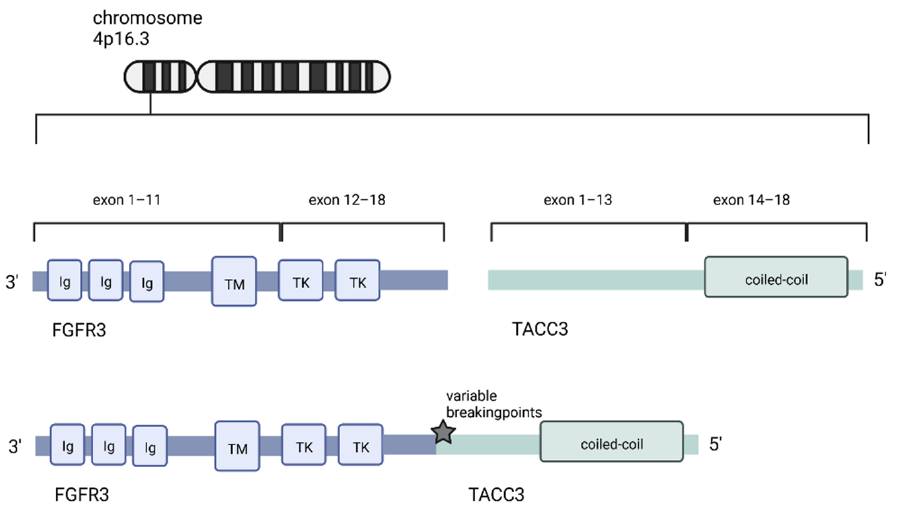
Figure 2. The FGFR3 and the TACC3 gene are both located on chromosome 4p16.3. The oncogenic fusion gene codes for FGFR3, harboring an intact kinase domain fused to the TACC3 gene, including the functioning coiled-coil domain (created with biorender.com, accessed on 21 May